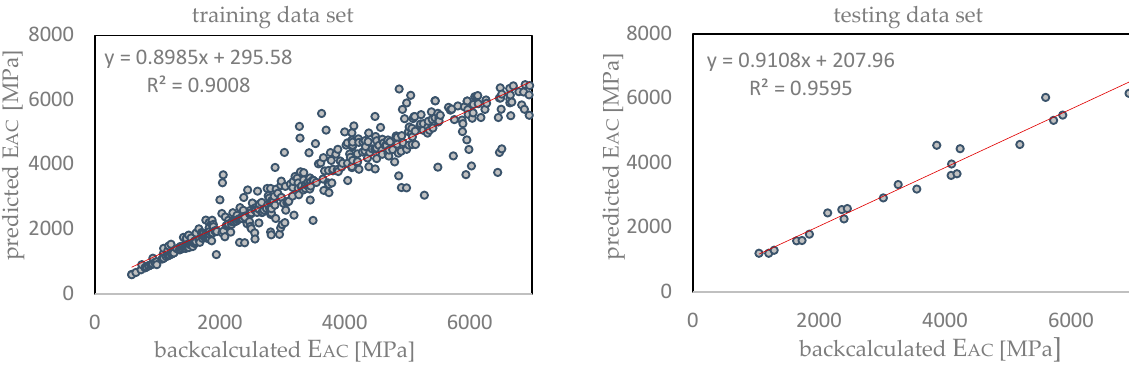
Figure 8. Comparison of predicted E AC with backcalculated E AC —Model SVM.